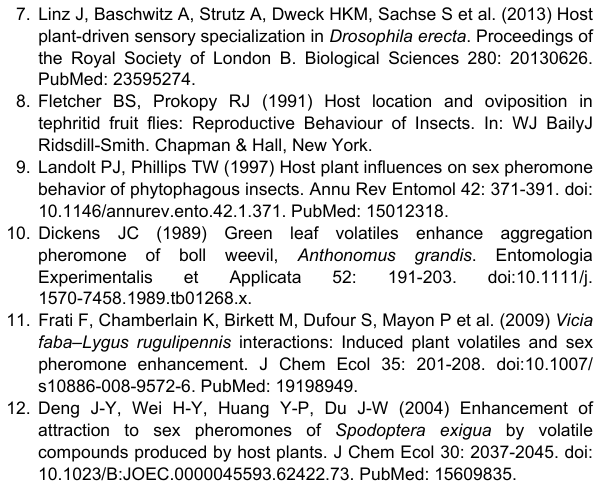
Figure S1. Effect of α-pinene on female olive fruit fly copulation parameters. Latency to mate and copula duration. Solid and open bars stand for exposed females to 20 μl α- pinene and non-exposed females respectively. N